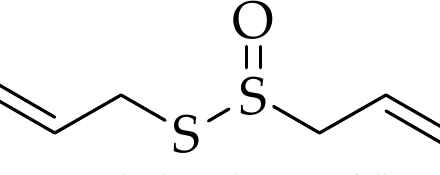
Figure 4. The chemical structure of allicin.